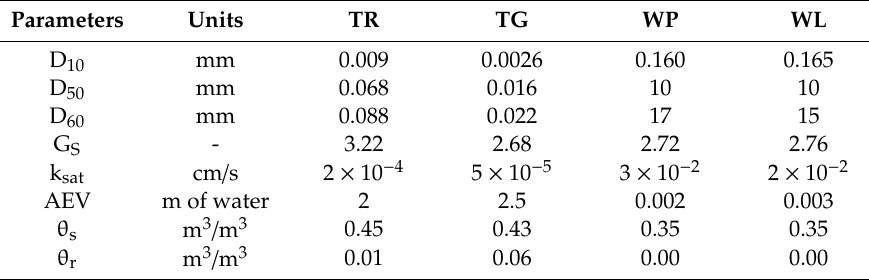
Parameters Parameters